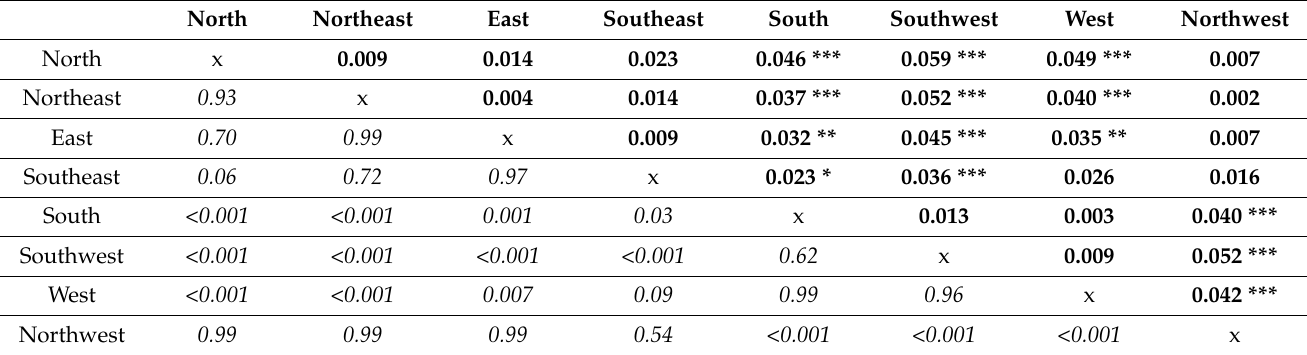
Figure 15. Spider web diagram showing a correspondence of higher mean RDI values for southerly oriented areas.